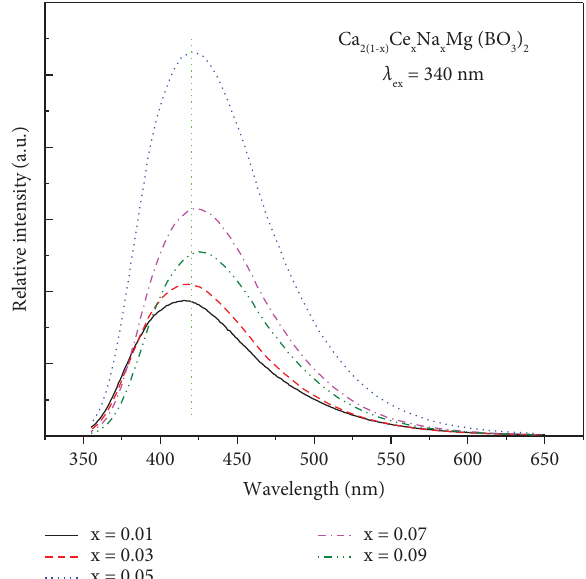
Figure 5: Te emission spectra of Ca 2(1 − x ) Ce x Na x Mg(BO 3 ) 2 ( x � 0.01, 0.03, 0.05, 0.07, and 0.09) samples with λ ex � 340nm.